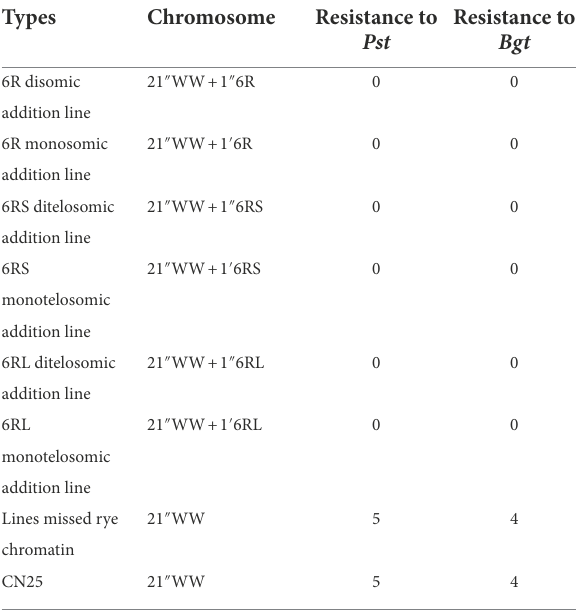
TABLE 4 Relationship between resistance and chromosome